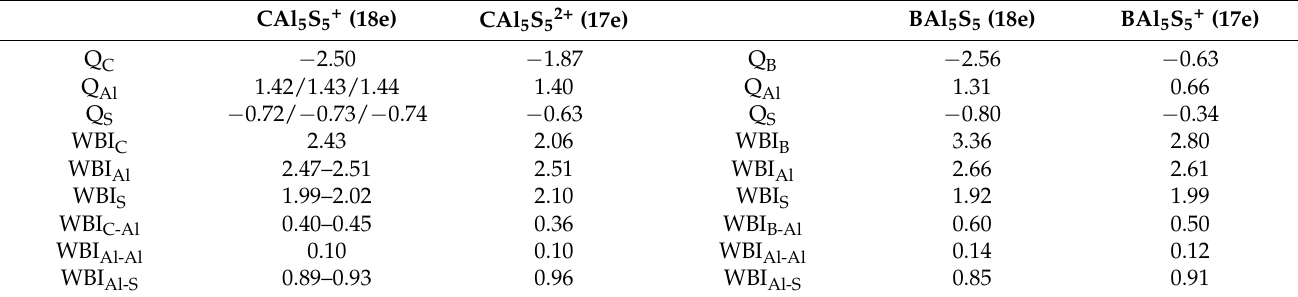
Table 1. Important NPA charges and Wiberg Bond Indices (WBIs) of CAl 5 S 5+ , CAl 5 S 52+ , BAl 5 S 5 , BAl 5 S 5+ .